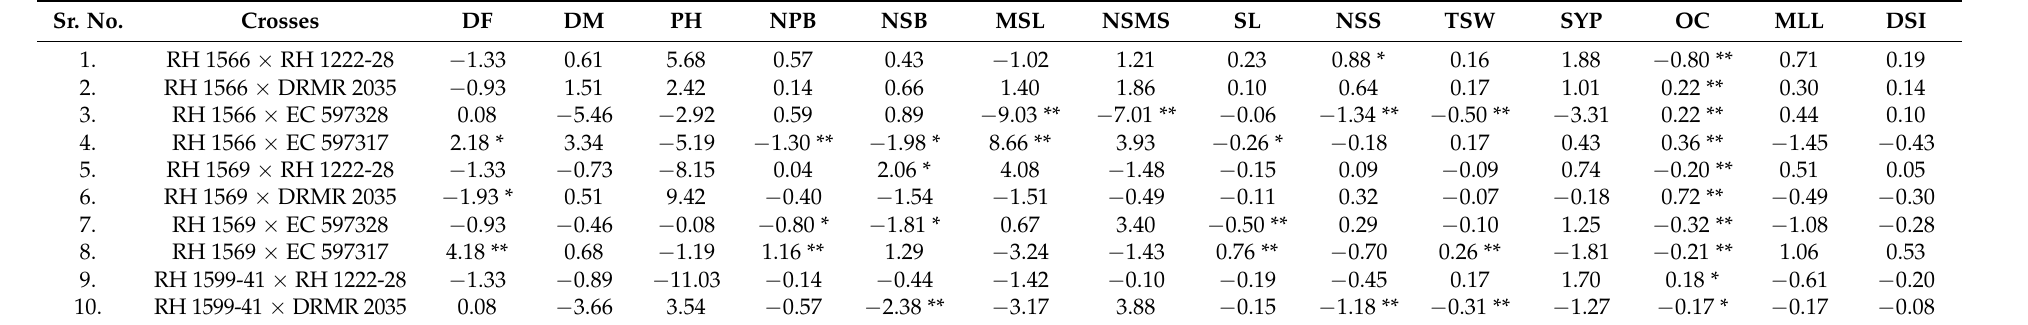
Table 5. Specific combining ability (SCA) of different crosses for seed yield and its component traits and Sclerotinia stem rot resistance in Indian mustard. Sr.